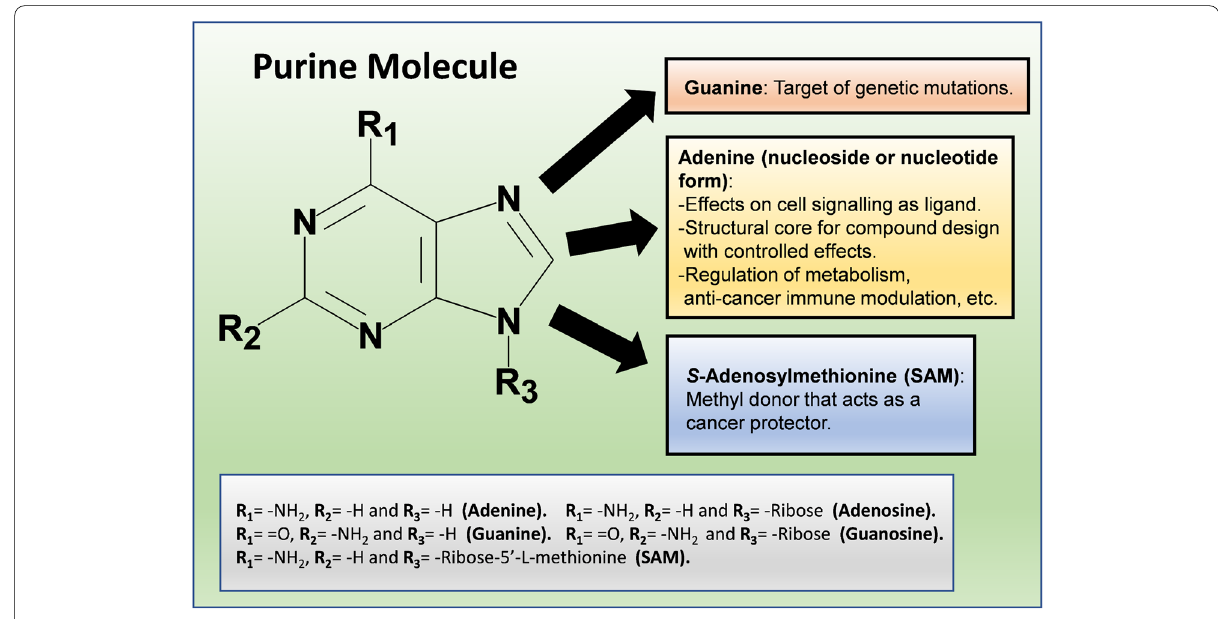
Fig. 1 Summary of purines structure and cellular